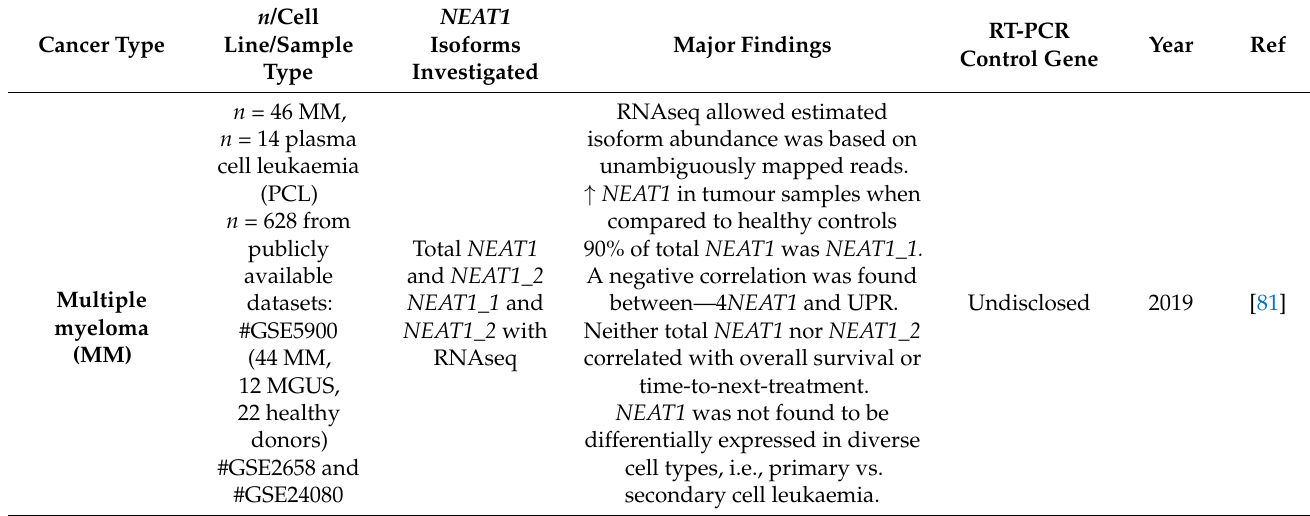
Table 1. Summary of NEAT1 expression studies, as determined by RT-PCR, in various human cancer subtypes, published between 2014 and